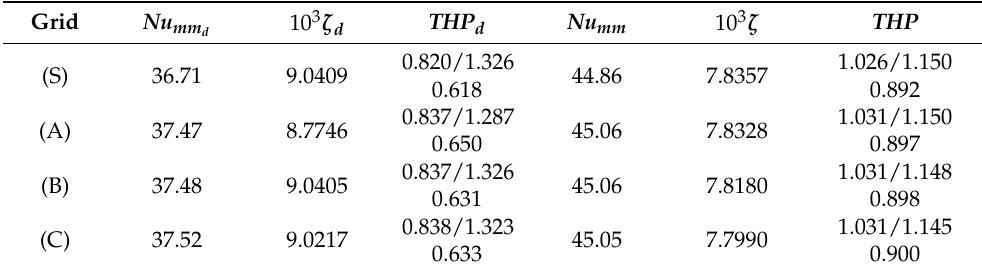
Table 1. Thermal and thermal-hydraulic performances of the control area and the hydraulic losses of different density